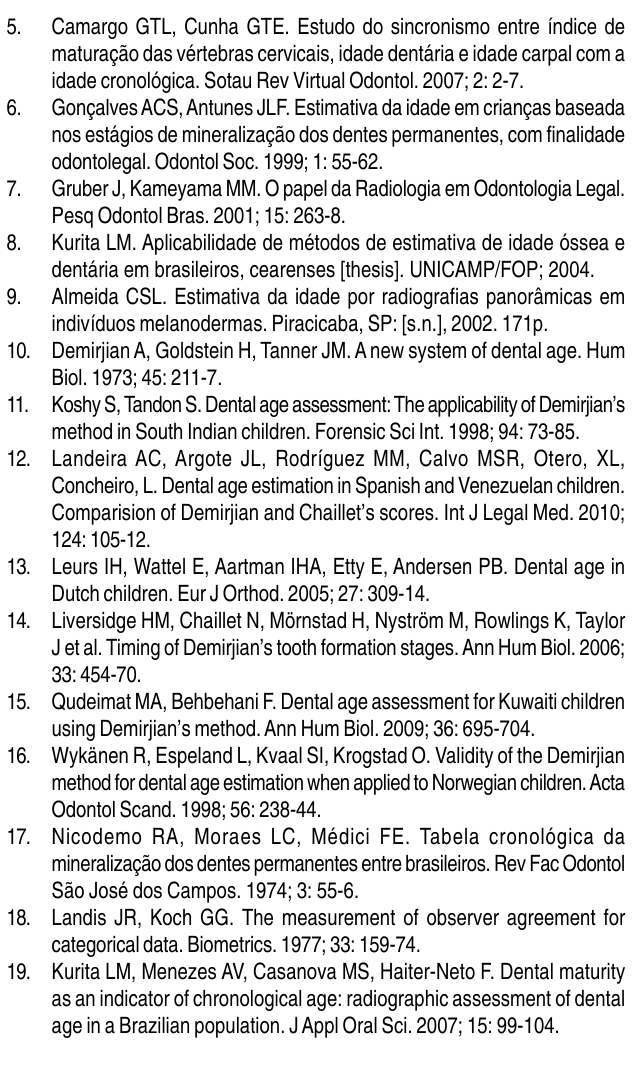
table of third molar mineralization in a survey in the state of Alagoas,